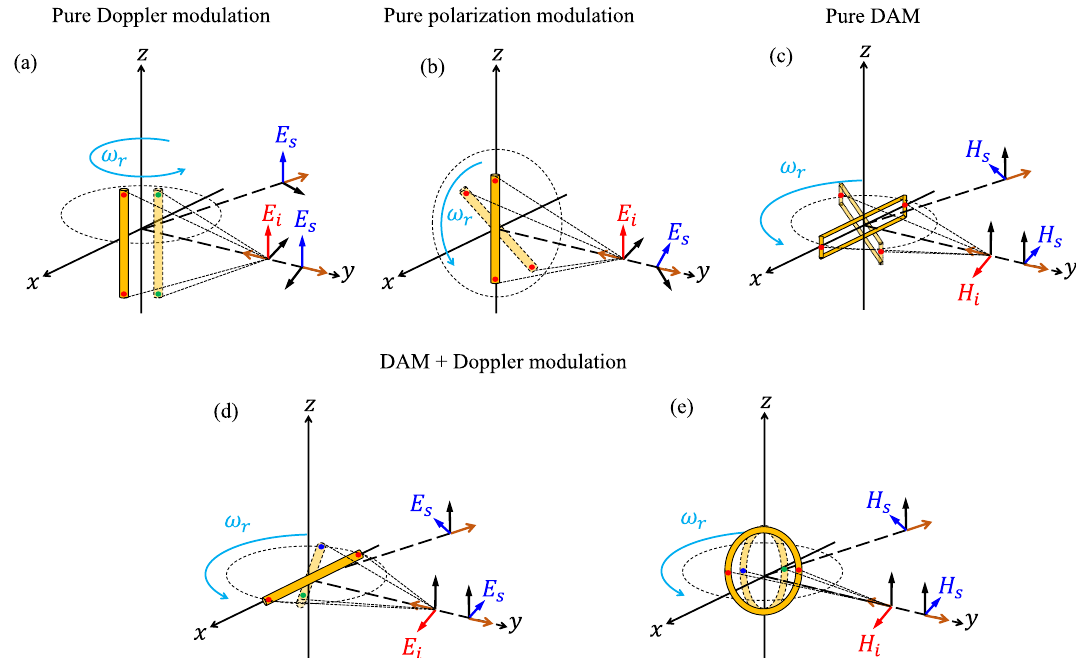
Figure 10. Backscatter communication based on rotating scatterers with ( a ) pure Doppler modulation, ( b ) pure polarization modulation, and ( c ) pure DAM. ( d,e ) backscatter communication with combined DAM and Doppler modulation. The phase change of the induced current on the scatterer during the rotation in ( d,e ) is shown by two red dots for normal incidence, and one blue and one green dot for oblique